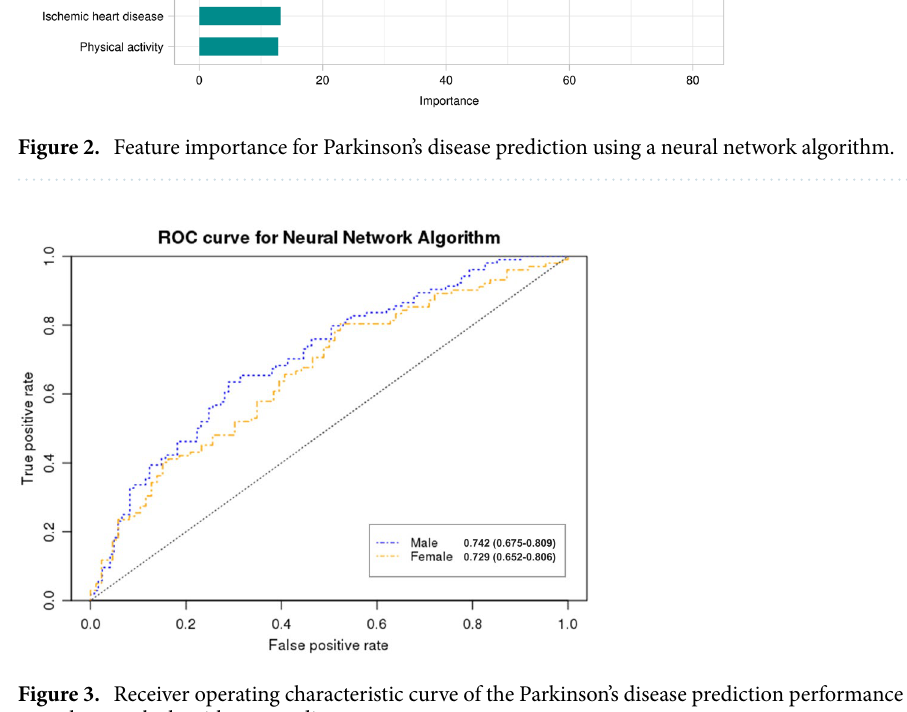
Figure 3. Receiver operating characteristic curve of the Parkinson’s disease prediction performance for the neural network algorithm according to sex.